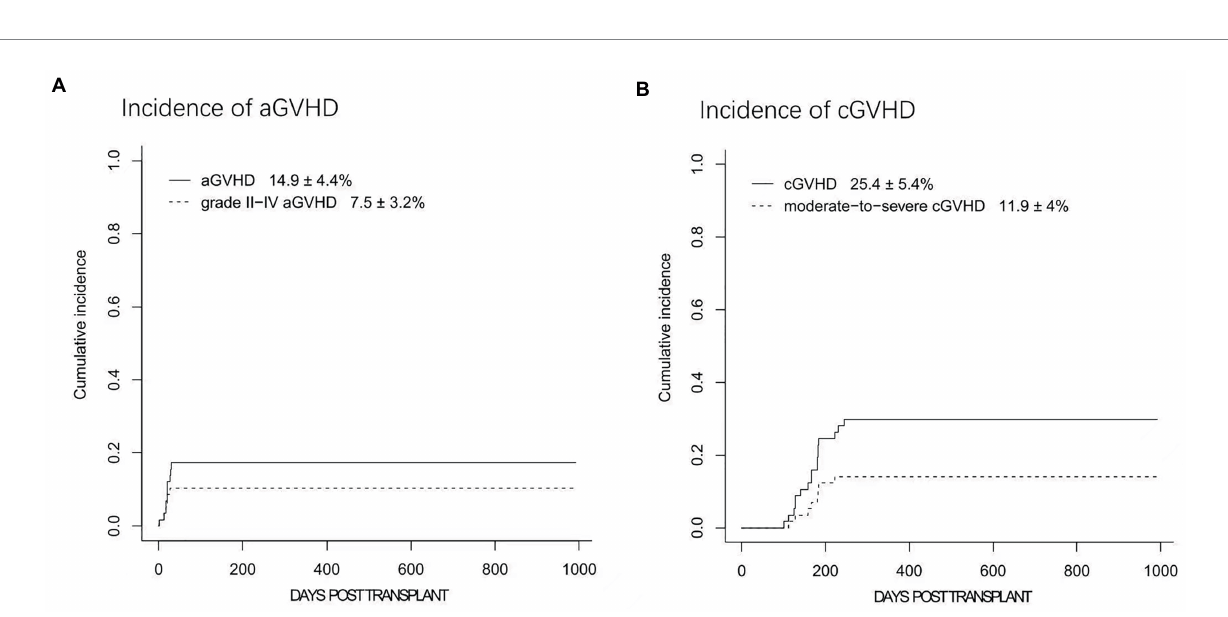
FIGURE 4 The cumulative incidences (CIs) of acute graft-versus-host disease (aGVHD) and chronic graft-versus-host disease (cGVHD). (A) The CIs of grades I-IV aGVHD and grades II-IV aGVHD. (B) The 2-year CIs of cGVHD and moderate to severe